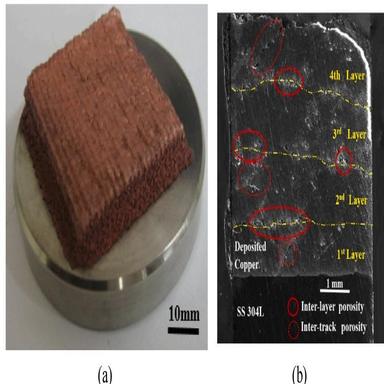
Decreasing LEPF scheme (a) Pictorial view of block (b) Cross-section showing porosity.